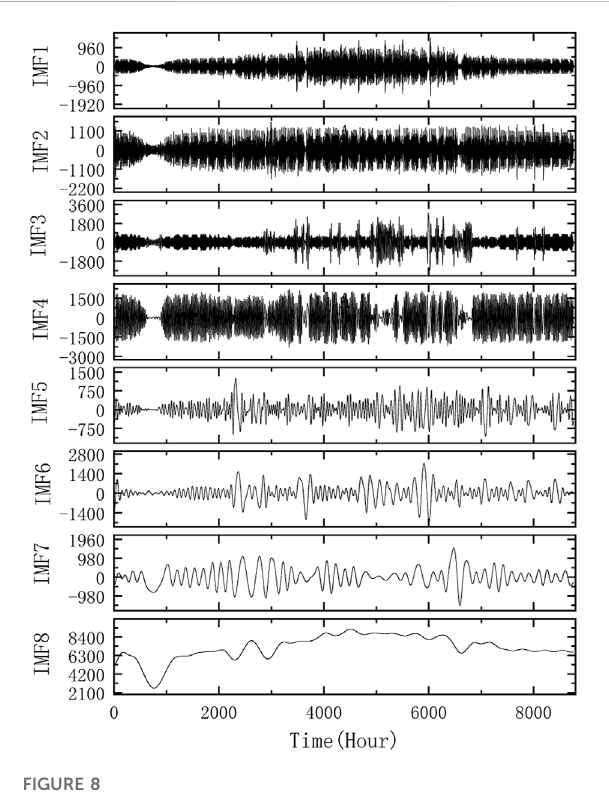
CEEMDAN-FE processing results of Case 1.